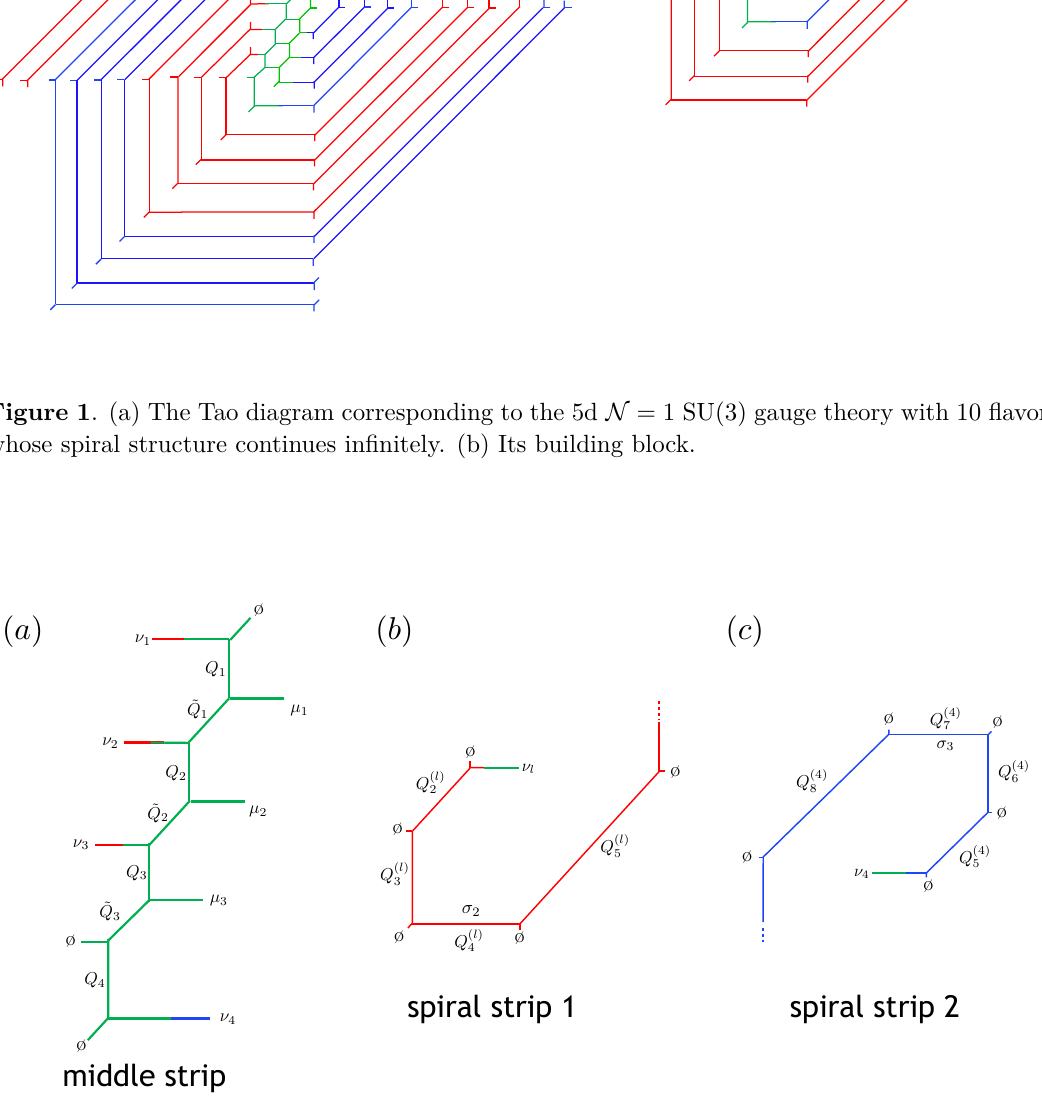
Figure 2 . The three kinds of building blocks of figure 1 (b). Here we call them (a) middle strip, (b) spiral strip 1, and (c) spiral strip 2. Greek letters ν l ( i = 1 , 2 , 3) denote the Young